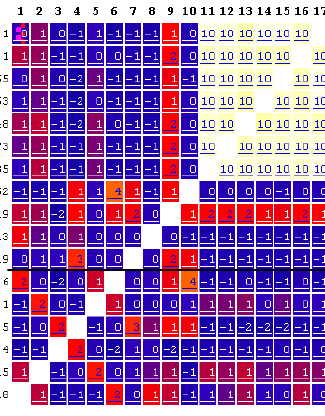
4: The antisense probes are correlated, the sense probes are correlated. The antisense probes are not correlated or have low correlations with the sense probes. 5: The probes are not correlated or are negatively